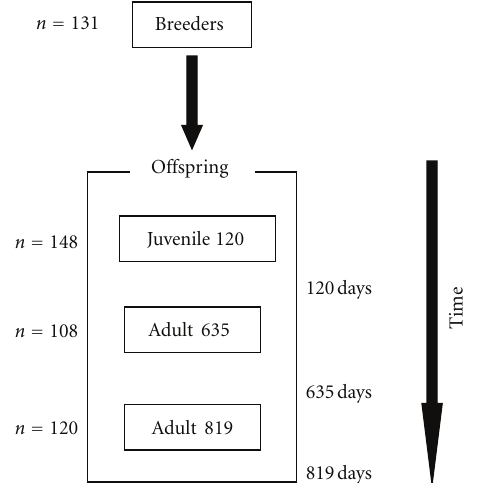
Figure 1: Schematic diagram of sampling during the di ff erent life